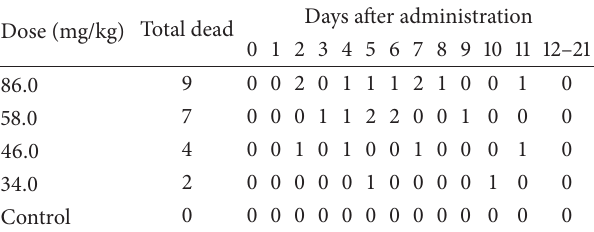
Table 1: Determination of the LD